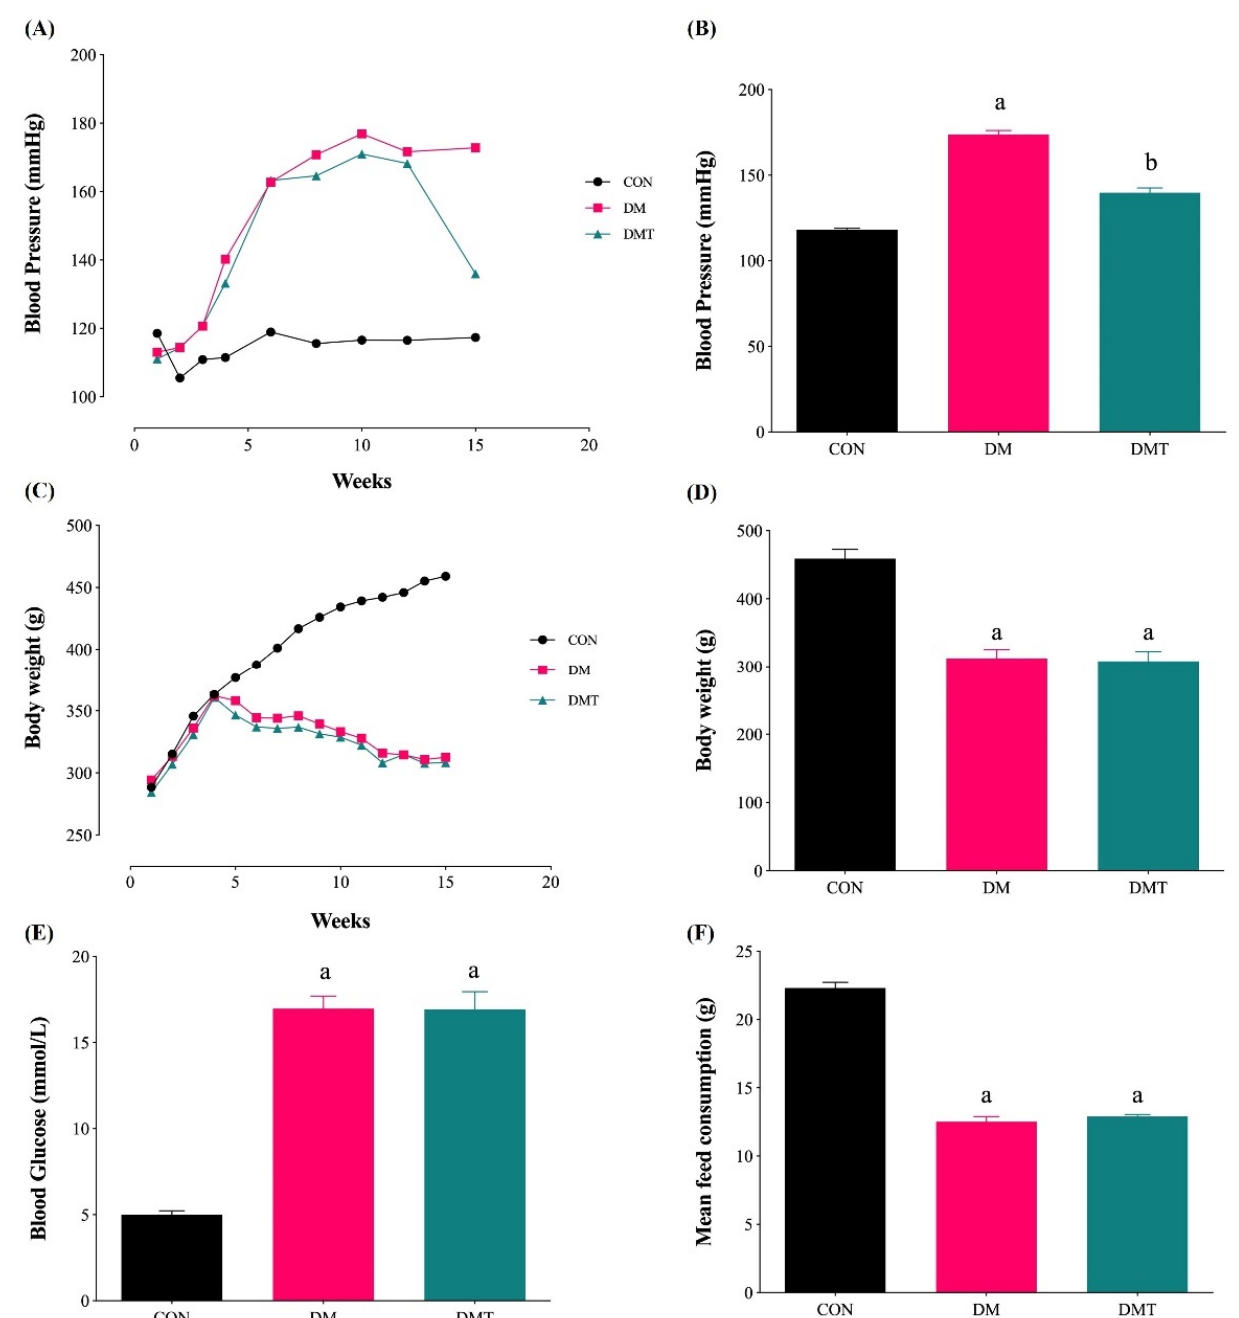
Figure 1. BP, body weight, blood glucose level, and mean food consumption in experimental groups. ( A ) BP changes throughout time, ( B ) BP at week 15, ( C ) body weight changes throughout time, ( D ) body weight at week 15, ( E ) blood glucose level at week 15, and ( F ) mean food consumption for the whole study duration (n = 9). Abbreviations: CON; Control, DM; Diabetes, DMT; Diabetic receiving TUDCA, and TUDCA; Tauro-ursodeoxycholic acid. a p < 0.05, vs. CON, b p < 0.05, vs. DM.